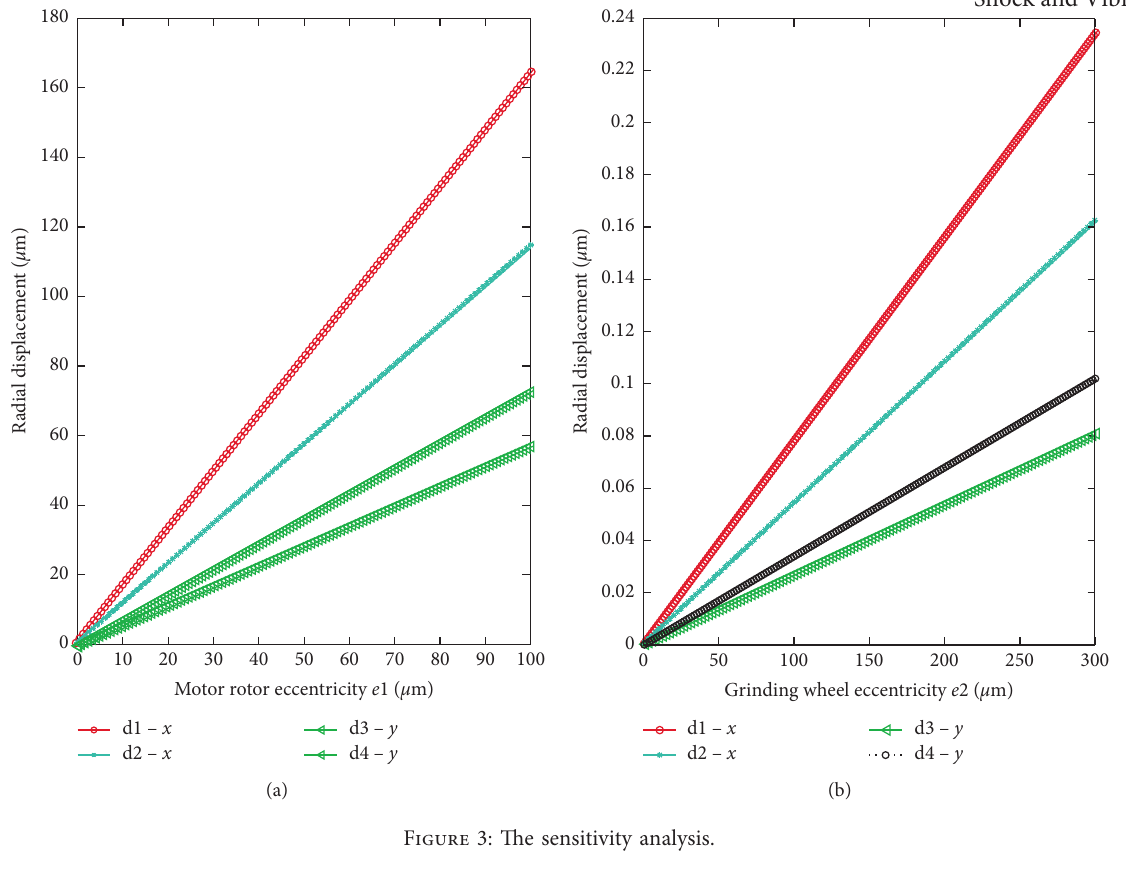
Figure 3: The sensitivity analysis.